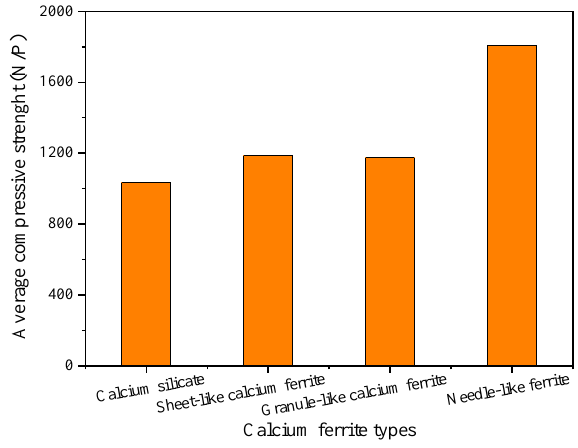
Figure 16. Average compressive strength of typical kinds of minerals.